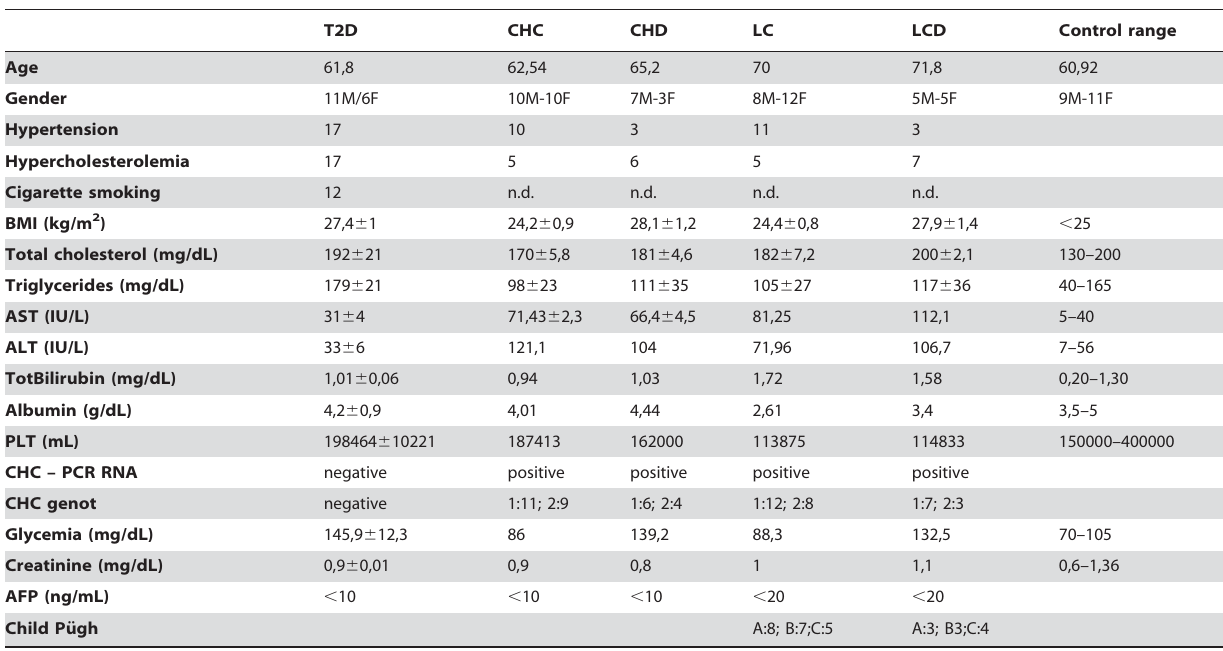
Table 1. Biochemical characteristics of all